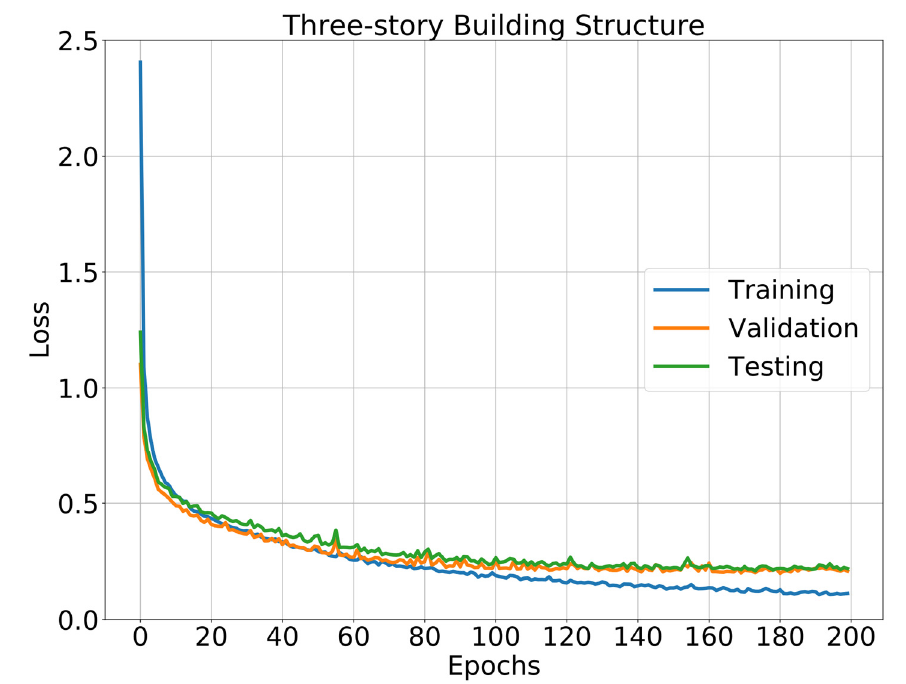
Figure 8. Training loss history of the FFT-DCNN algorithm.